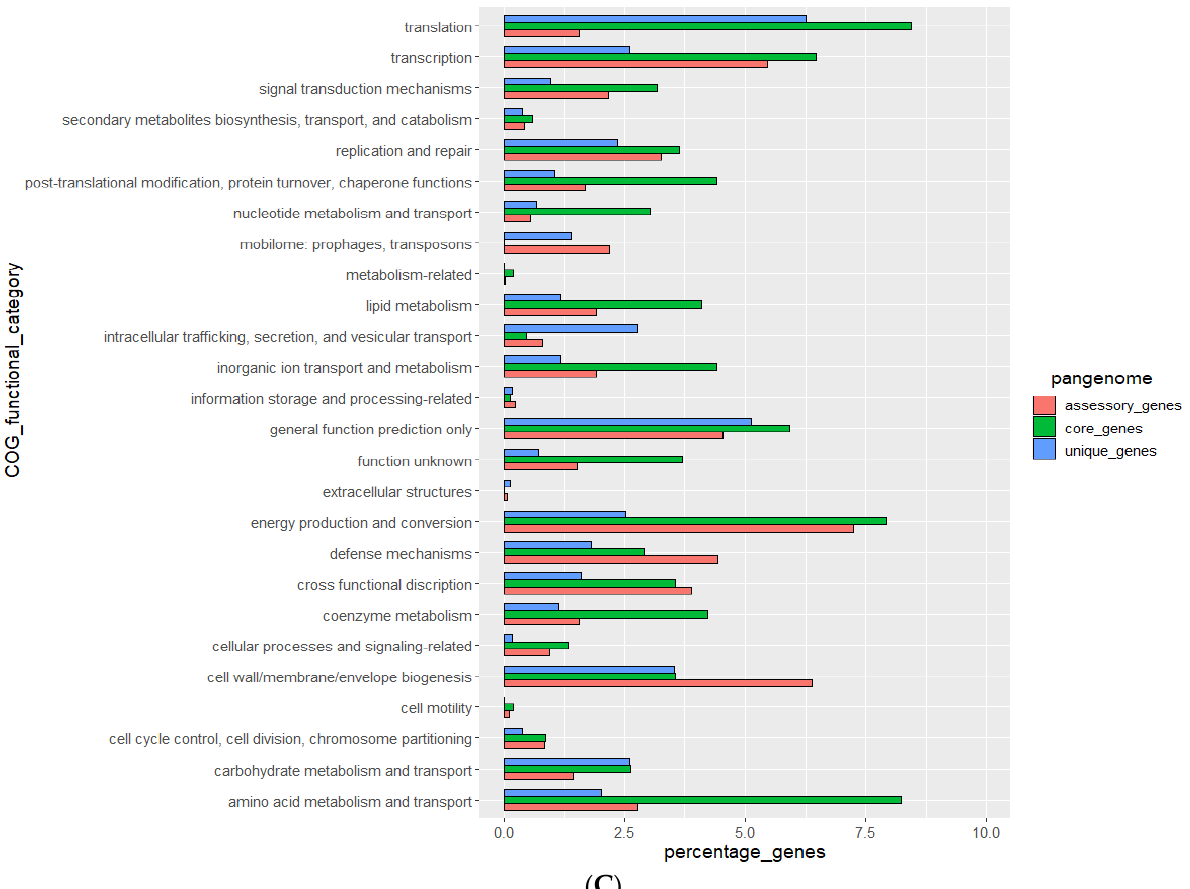
Figure 2. ( A ) Distribution of genes in the pangenome among each of the examined 57 genomes of cultivated E. lenta isolates. ( B ) Analysis of dereplicated genomes of E. lenta ( n = 57) shows the genus possesses a pan and core genome of 8273 and 1425 genes, respectively. ( C ) OGs of the pangenome (core, accessory and unique genes) of 57 E. lenta isolates and their functional assignment using the COG database, the fraction of OGs assigned no function is excluded from illustration.